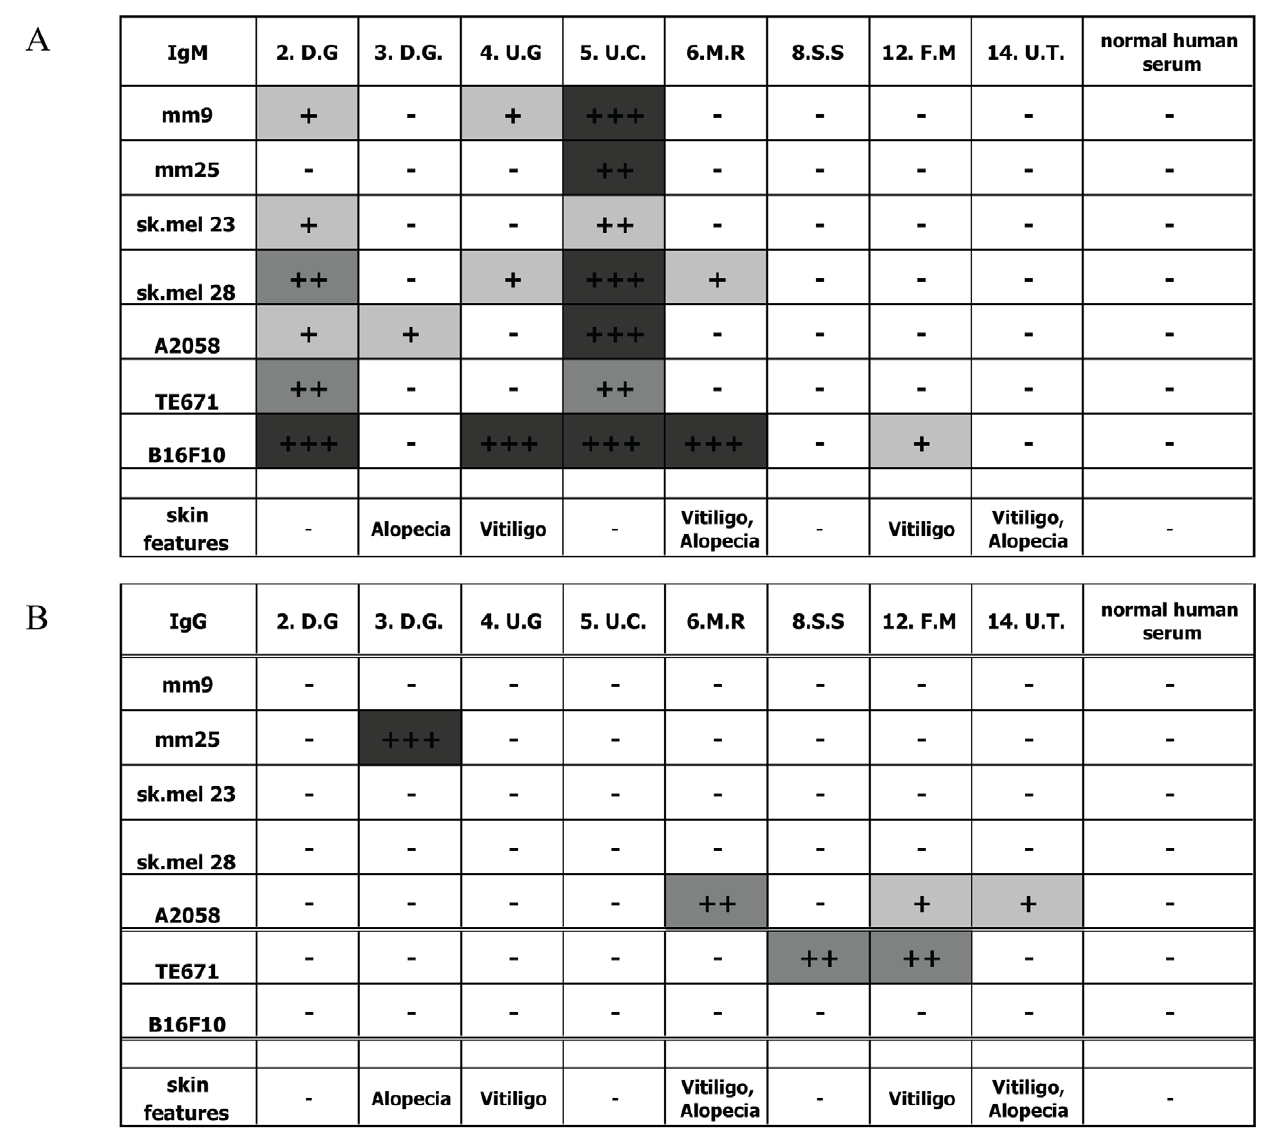
Figure 1. APECED patients with skin features have increased anti-melanoma antibody levels. Cell lines were stained with serum obtained from APECED patients (2.D.G, 3.D.G., 4.U.G., 5.U.C., 6.M.R., 8.S.S., 12.F.M., 14.U.T.) diluted 1/500. Mm9, mm25, sk.mel23, sk.mel28, A2058 are human melanoma lines, TE671 a human rhabdomyosarcoma, and B16F10 murine melanoma cell line. Background using normal human serum was substracted and mean fluorescence indicated as follows 2, 0.5, + 0.5–0.75, ++ 0.75–1, +++ . 1. The secondary antibodies used were A anti-human IgM FITC and B anti-human IgG FITC.